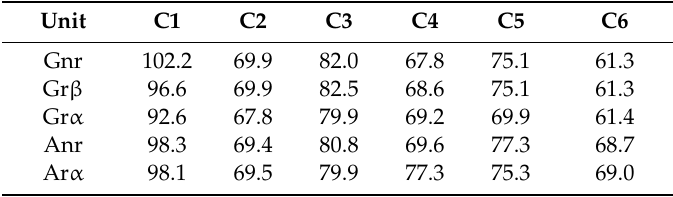
Table 4. Chemical shift assignments for 13 C-NMR spectra of NAOS.